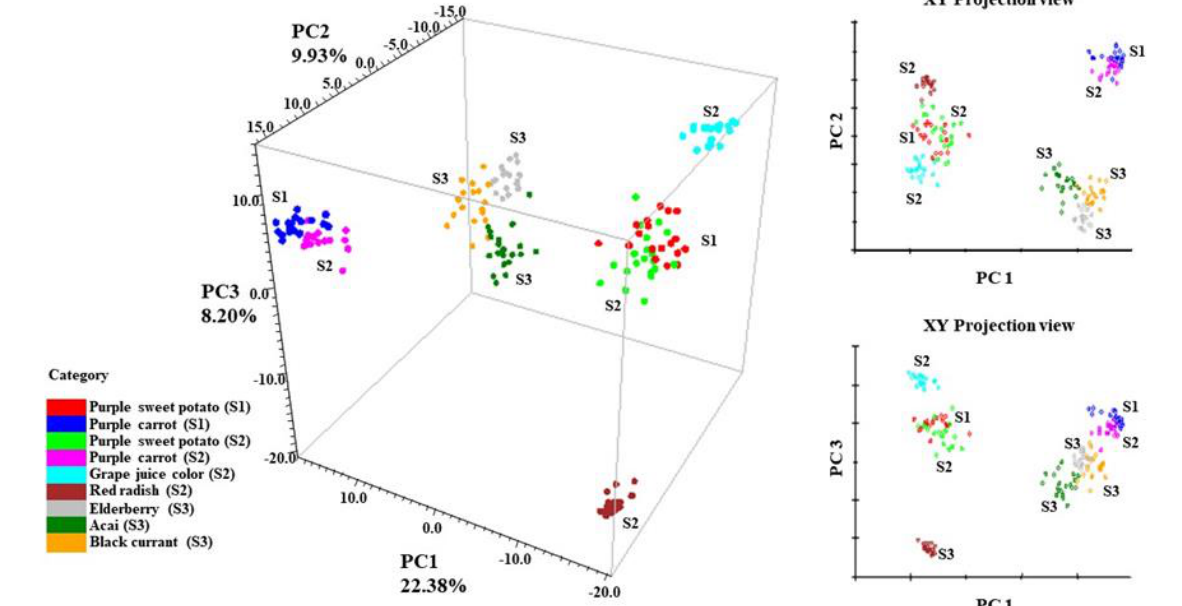
Figure 4. PCA scores of collected anthocyanin SERS signal, S1 (Supplier 1); S2 (Supplier 2); S3 (Supplier 3).